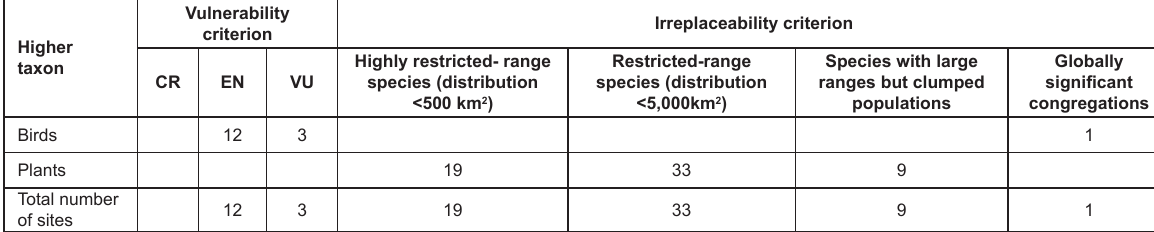
Table 2. Summary of the numbers of KBAs triggered by each of the criteria/subcriteria for each higher taxonomic group